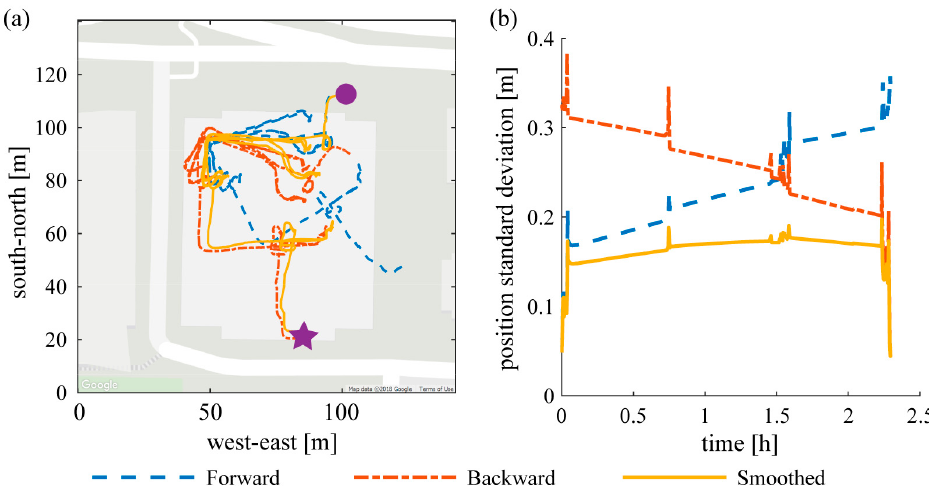
Figure 2. Comparison of ( a ) forward (blue dashed line), backward (red dash-dot), and smoothed (yellow solid) position and ( b ) their standard deviations during a 2+ hour indoor period. The subject entered the building from the north (round dot on the left graph), stayed more than 2 h in the building and left from the south (star on the left graph). It can be seen that forward filter’s position is accurate at first but gradually drifts counter-clockwise; the backward filter’s position is accurate at the end but drifts clockwise in reverse time. The smoothed position follows the forward position at first and gradually shifts to the backward position, maintaining a smaller standard deviation throughout. Note that the standard deviations on the right graph are estimates from the Kalman filter and smoother, where only their relative magnitude is important.